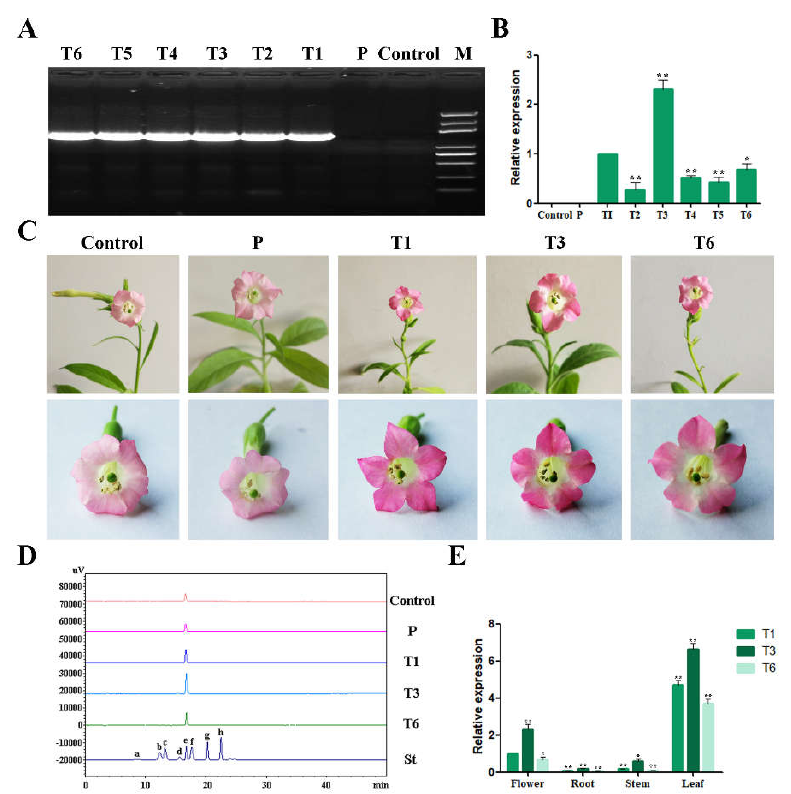
Figure 9. Analysis of tobacco lines overexpressing the RrGT2 gene. ( A ) The results of positive PCR detection in transgenic tobacco lines. ( B ) The results of qRT-PCR detection in transgenic tobacco lines. ( C ) Phenotypic comparison of flowers between the transgenic tobacco group and the control group and empty vector group. ( D ) HPLC-derived chromatograms of the flowers of the control group, empty vector group and three transgenic tobacco lines. Eight kinds of anthocyanin standards (St) were used for detection: (a) Dp3G5G; (b) Cy3G5G; (c) Dp3G; (d) Pg3G5G; (e) Cy3G; (f) Pn3G5G; (g) Pg3G; and (h) Pn3G. ( E ) Temporal and spatial expression patterns of RrGT2 in the three transgenic tobacco lines. The error bars represent the SDs of triplicate reactions. The experiment was repeated three times and each yielded similar results. * and ** indicate a significant difference in the relative expression levels at p < 0.05 and p < 0.01, respectively, according to Student’s t-test.